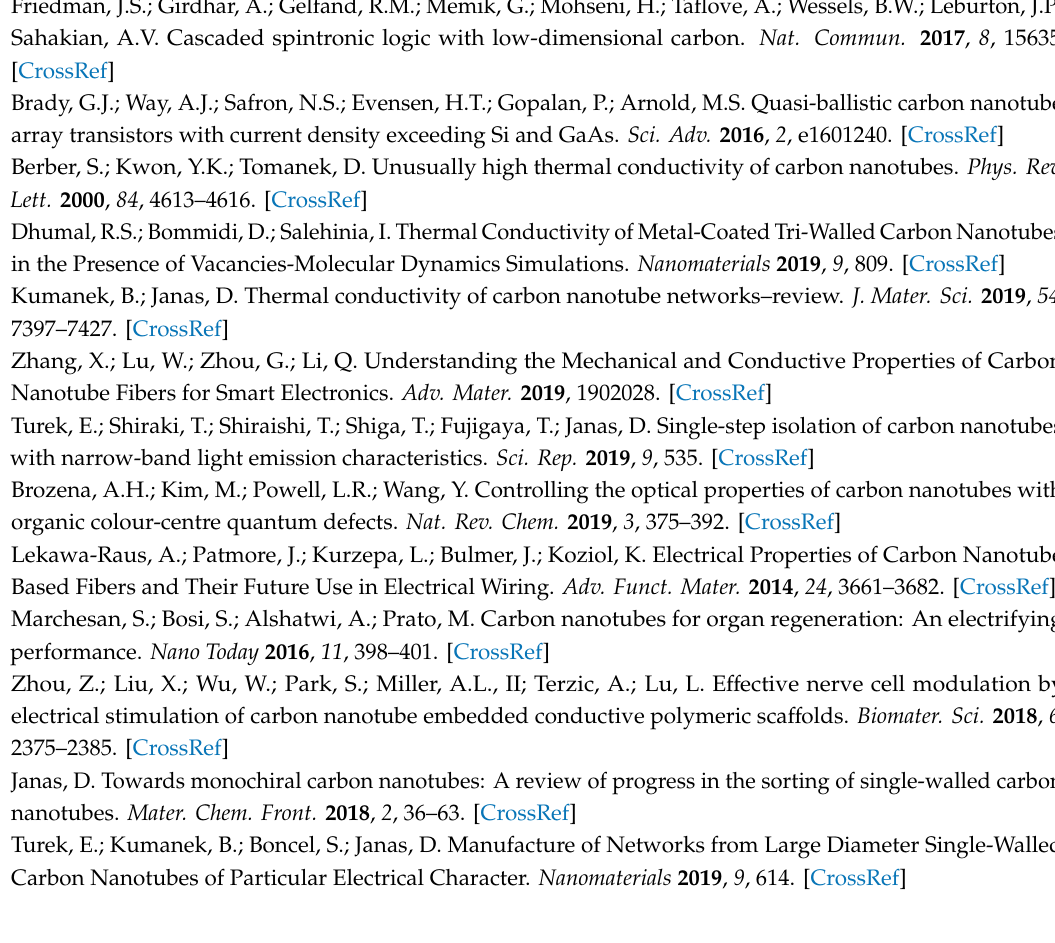
Figure S1: Co ff ee grinder (Profi Cook PC-KSW 1021, 200W) used for the